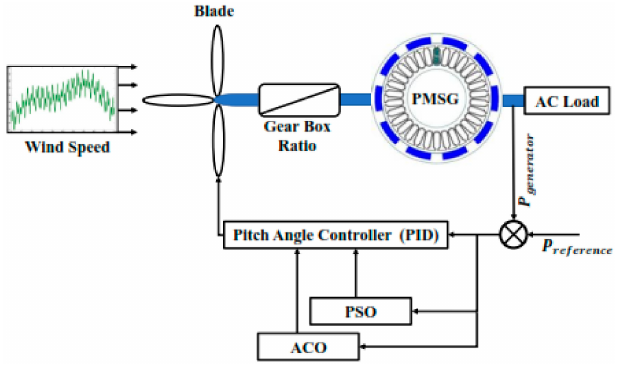
Figure 1. Block diagram of wind power generation